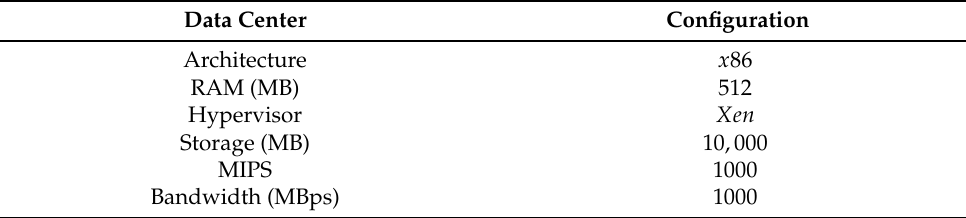
Table 6. Configuration of Data Center.